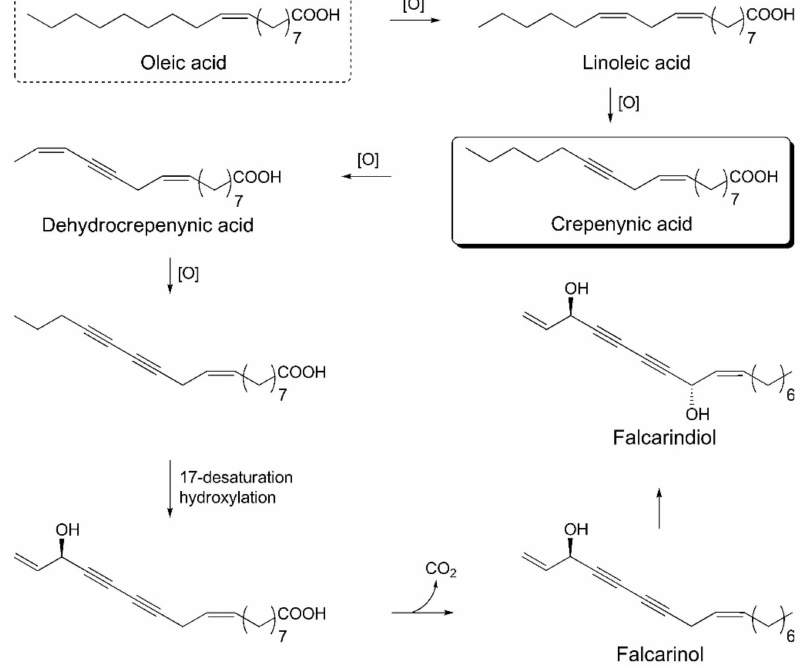
Figure 6. Schematic biosynthetic pathway for falcarinol type